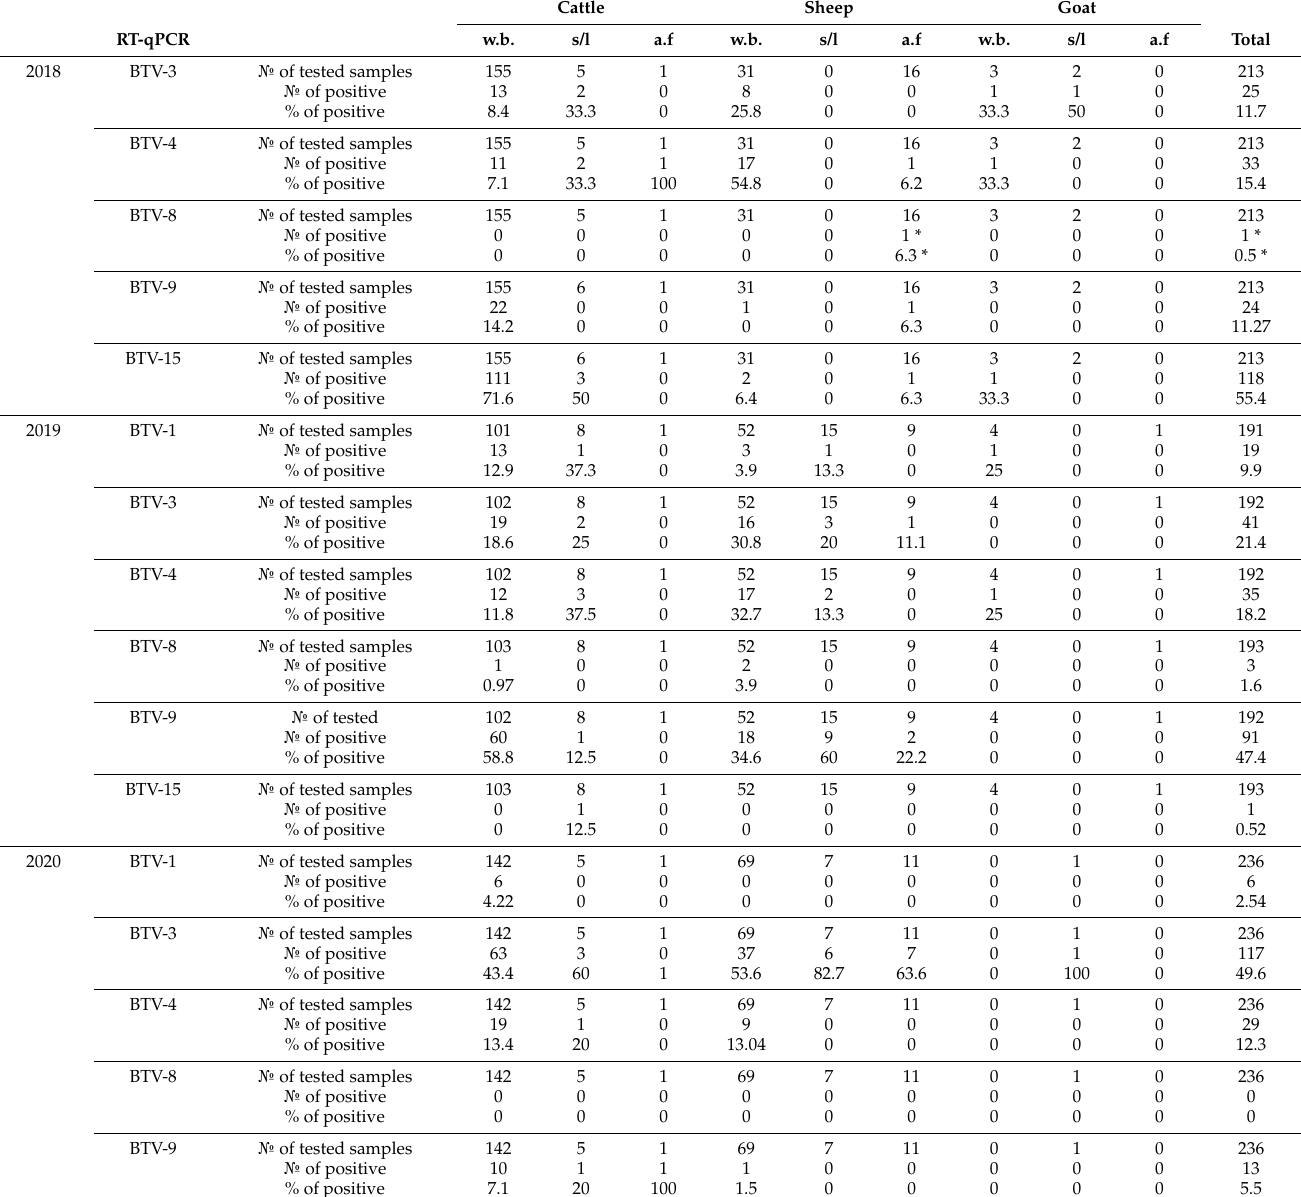
Table 2. Positive samples from domestic ruminants tested in serotype-specific qPCR during 2018–2020. Cattle Sheep Goat